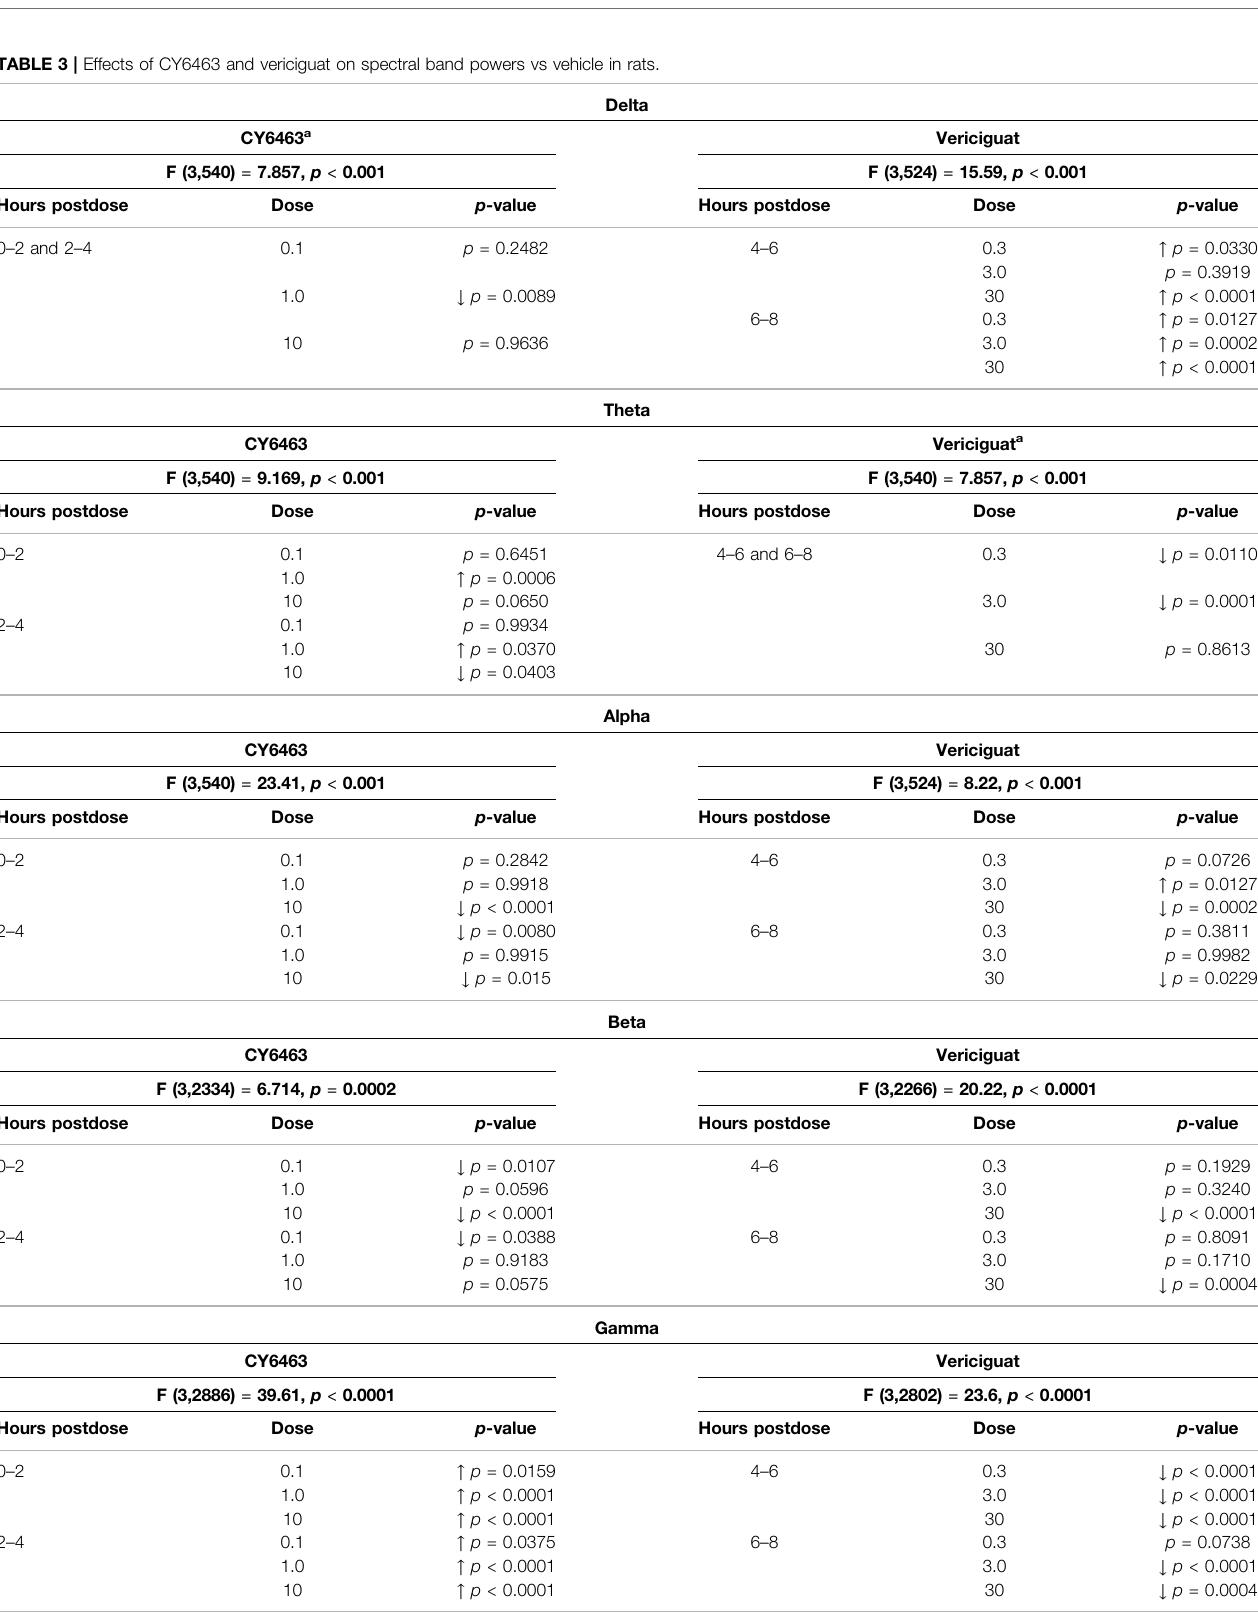
TABLE 3 | Effects of CY6463 and vericiguat on spectral band powers vs vehicle in